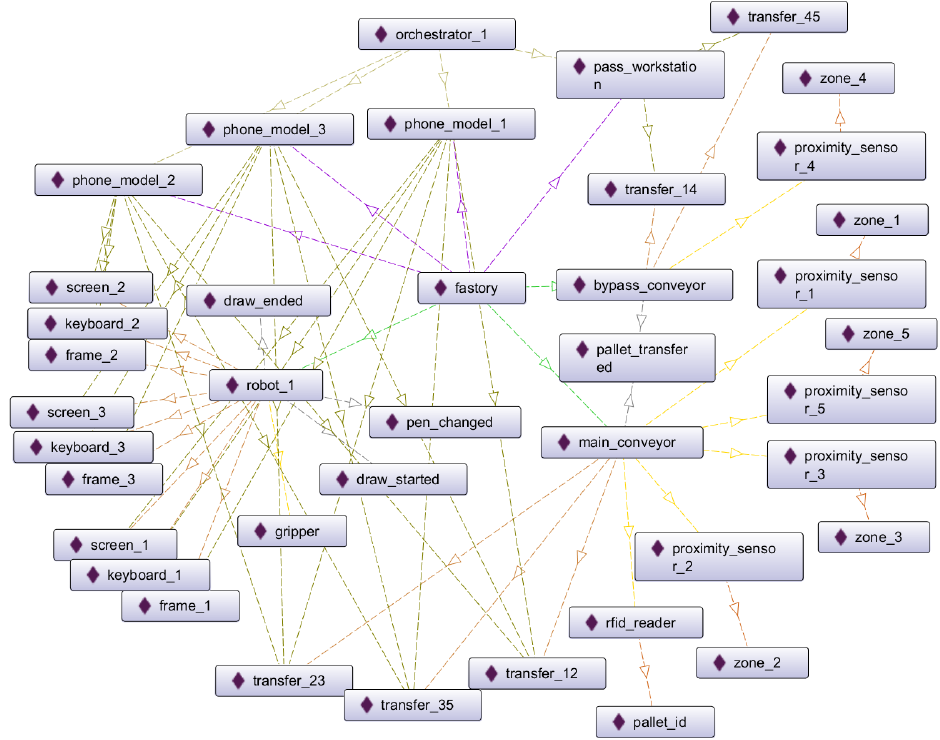
Figure 12. FASTory production description for drawing process. [Source: Own figure which is a snapshot from Protege Ontology